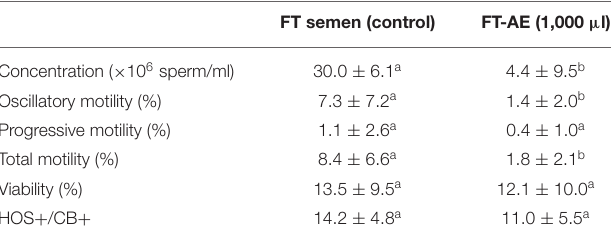
TABLE 3 | Sperm concentration, motility (oscillatory, progressive, and total), viability, and spermatozoa with functional membranes and an acrosome present (HOS + CB + ) in frozen-thawed (FT) llama semen (untreated control) and FT samples centrifuged 20min through 1,000 µ l of Androcoll-E TM columns (FT-AE).